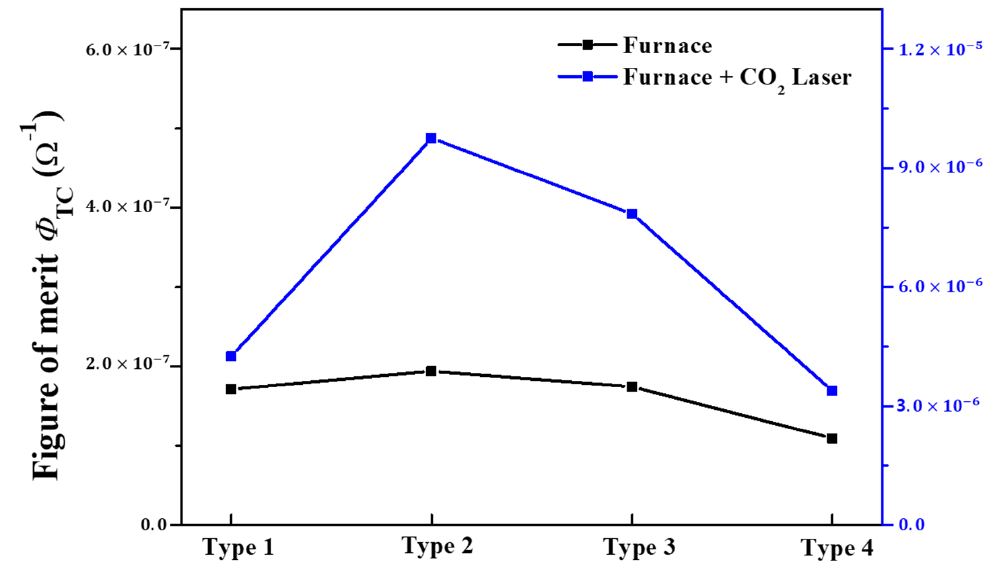
Figure 10. Figure of merit of four types of (In, Ga) co-doped multilayered thin films after electrical furnace and furnace & CO 2 laser annealing.